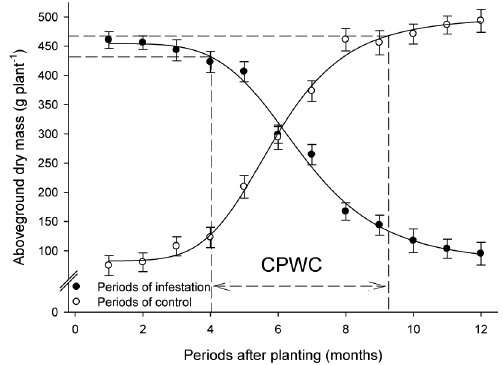
of Hevea brasiliensis submitted to crescent periods of weed infestation or weed control. CPWC is the critical period for weed control. Vertical bars indicate the standard error of the means.